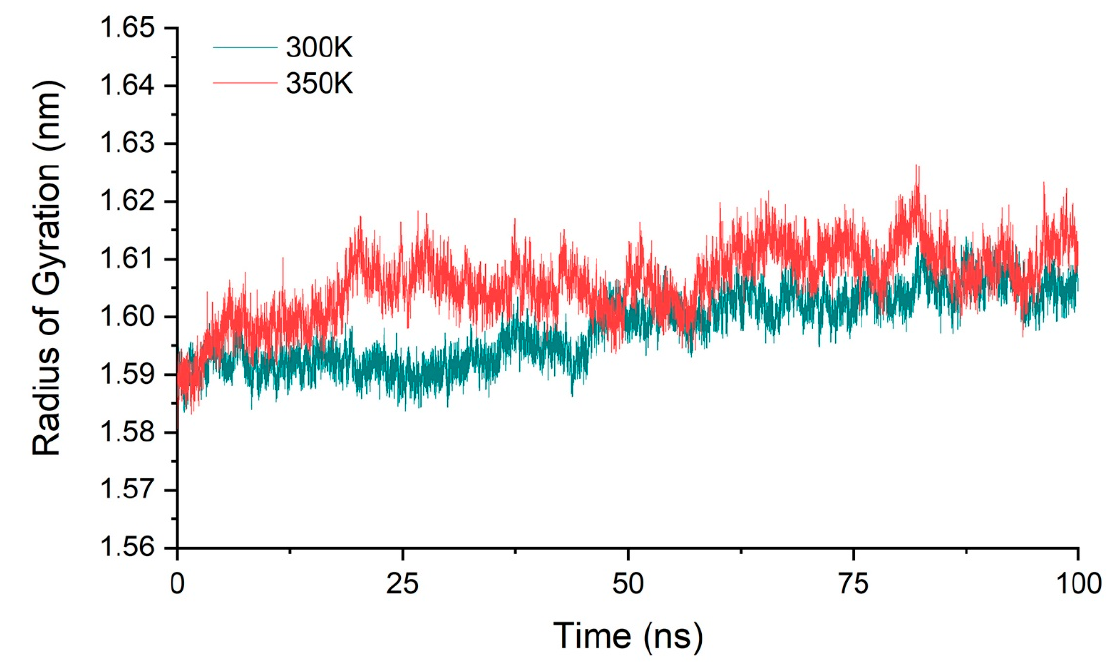
Figure 5. The average radius of gyration of three simulations at 300 K and 350 K. To fully consider all the conformations that had been sampled, we concatenated the trajectories of the three simulations at each temperature, then calculated the RMSF of C α atoms in the two concatenated trajectories and compared them (Figure 6A). It has been shown that the difference in RMSF between systems with different temperature can be used to indicate the flexibility of a protein or a region to temperature [29]. We found that loop 3 had the highest flexibility at 300 K (over 0.5 nm) followed by loop 6 (over 0.3 nm), while loops 7 and 10 also fluctuated to some extent (below 0.2 nm). Flexibility at 350 K was only significantly higher than 300 K in a few regions rather than across the board. Loop 3 significant increase. Some regions in loop 6 and 11 showed a large increase, with some